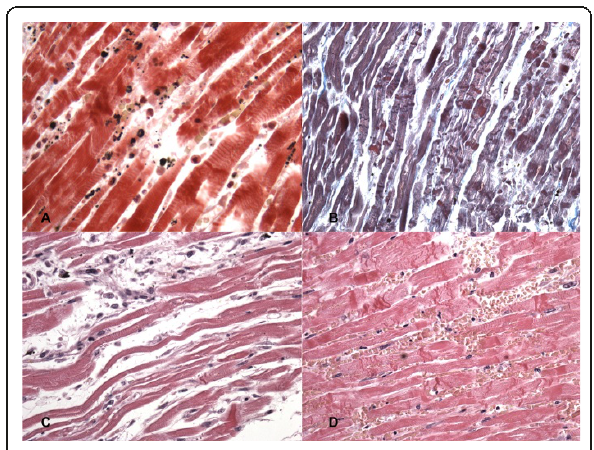
Figure 2 Microscopic findings . Acute myocardial infarction: polymorphonuclear leucocyte infiltration (A). Hypercontracted myocardial cells with markedly short sarcomeres and anomalous, extreme thickening of Z lines and rexis of the myofibrillar apparatus into cross-fibre, anomalous and irregular, up to a total granular disruption (B). Diffuse stretching of the myocardium with elongation of the sarcomeres and nuclei (C). Reflow areas